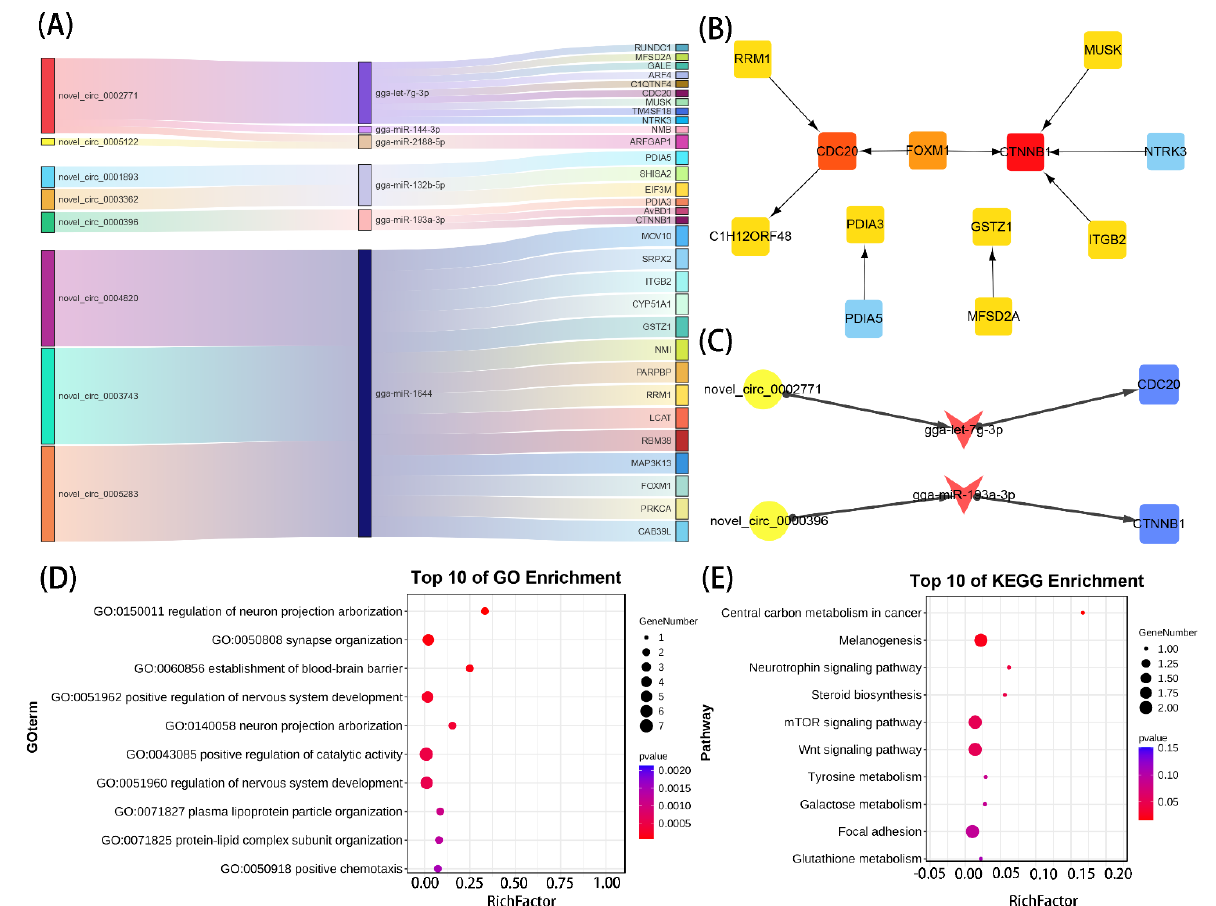
Figure 5. Construction of ceRNA network and screening of key regulatory axes: ( A ) Sankey diagram of ceRNA network; ( B ) PPI network of genes from the ceRNA network; ( C ) novel_circ_0002771/gga-let-7g-3p/CDC20, novel_circ_0000396/gga-miR-193a-3p/CTNNB1 regulatory axes; ( D , E ) top 10 GO-BP and KEGG enrichment analyses.